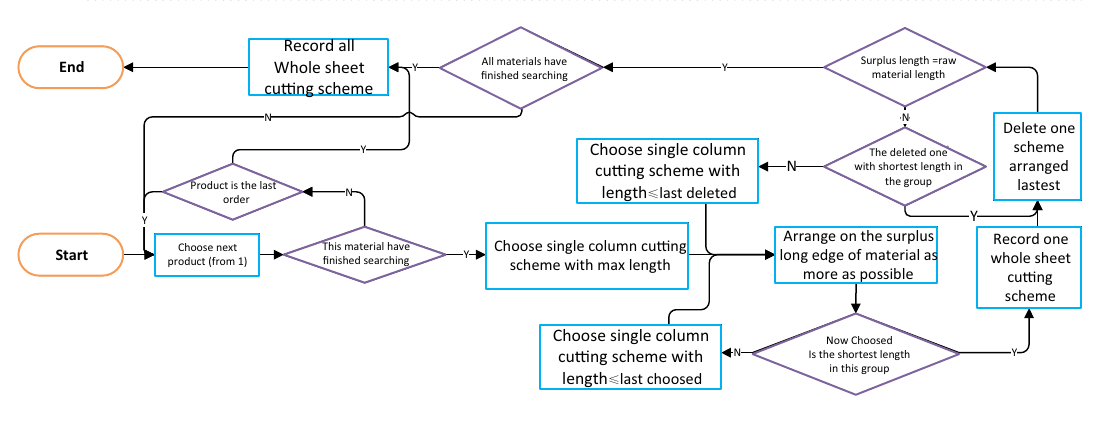
Figure 12. Flowchart of whole sheet cutting scheme search